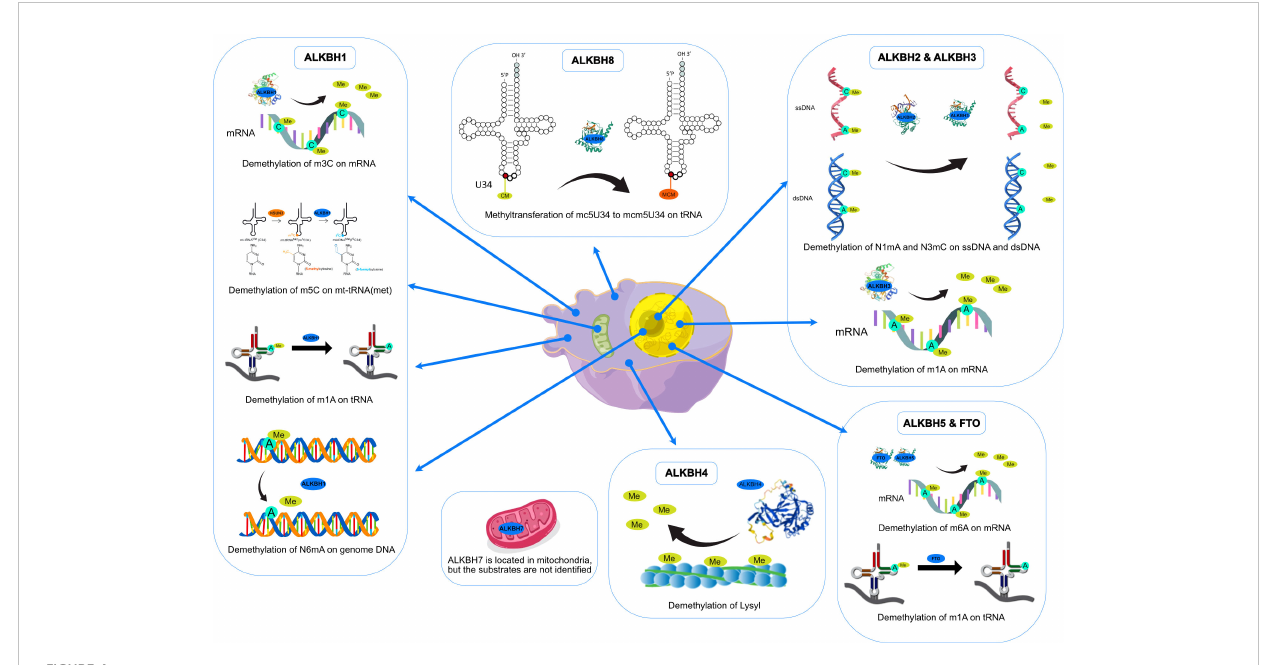
FIGURE 4 Functions and intracellular localizations of AlkB